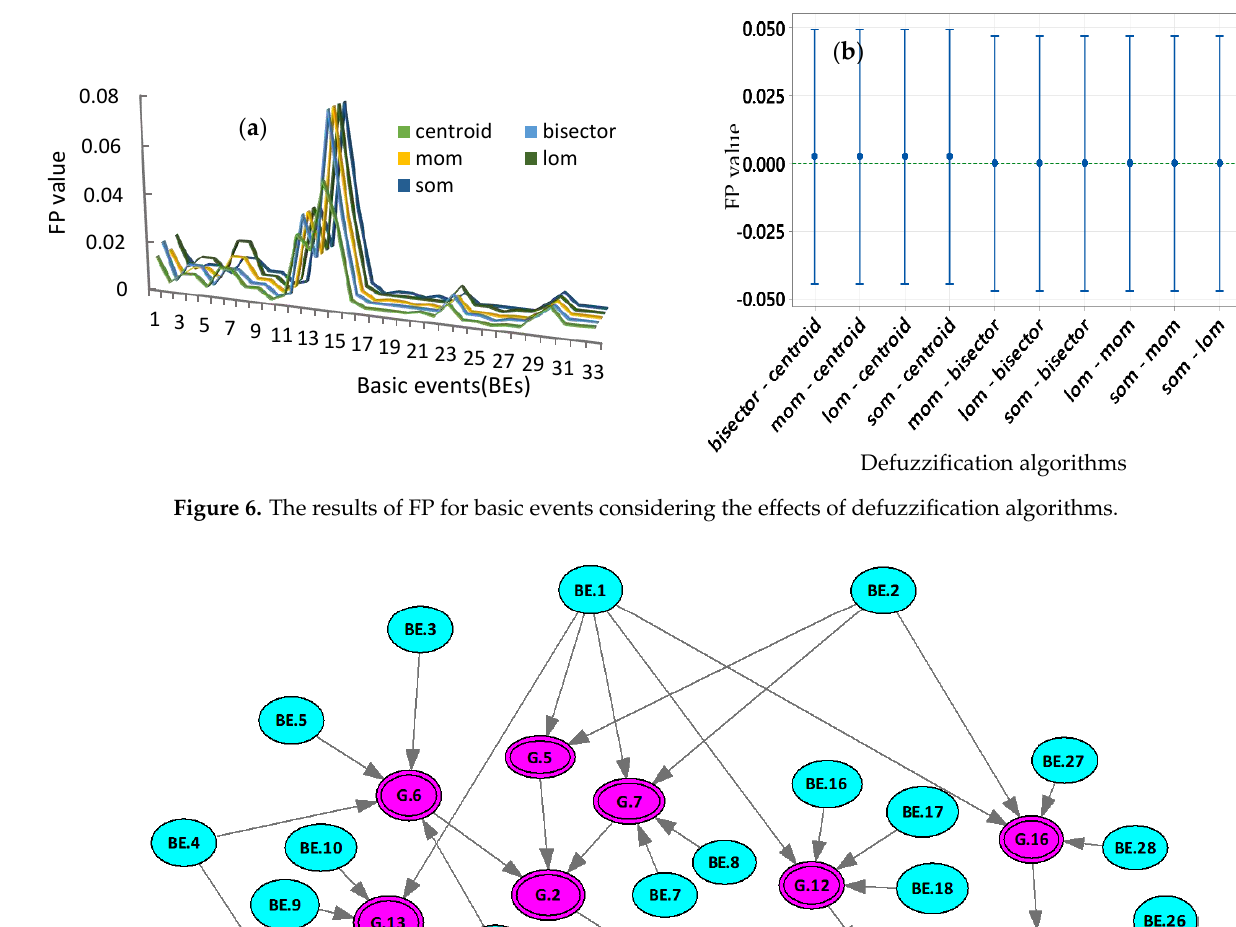
Figure 8. The conditional probability process of intermediate nodes based on logic gates in GeNIe 3.0 software. The average values of the FP derived from the FFTA method were used as the prior probability values of the root nodes in the Bayesian mechanism, to predict the posterior FP while considering all possible dynamic interactions between the BEs. Moreover, Figure 9 shows the comparison of the results of the FP based on the FFTA and BN models for the hydraulic – pneumatic circuit, electronic circuit, and filling headset of the filling system, along with their critical components. As can be observed, since the BN method approaches the dynamic relationship between events, the FP values are higher in most cases with that of the results of the FFTA model. According to the BN analysis, the FP of the leaf node (G.1), or failure of the whole filling system, was estimated as 0.206, for which the system reliability was approximately 0.813. Furthermore, the FPs of the intermediate nodes, in- cluding 3 subsystems, such as the filling headset (G.2), the hydraulic – pneumatic circuit (G.3), and the electronic circuit (G.4) were obtained as 0.057, 0.065, and 0.129, respectively, in which the reliability was around 0.945, 0.936, and 0.879, respectively. Among other sub- intermediate nodes, the ABS’s failure (G.15), the starter’s fault (G.14), the mini- valve’s fault (G.7), the pipe ’ s failure (G.8), and the c oupling’s fault (G.8) are allocated the highest